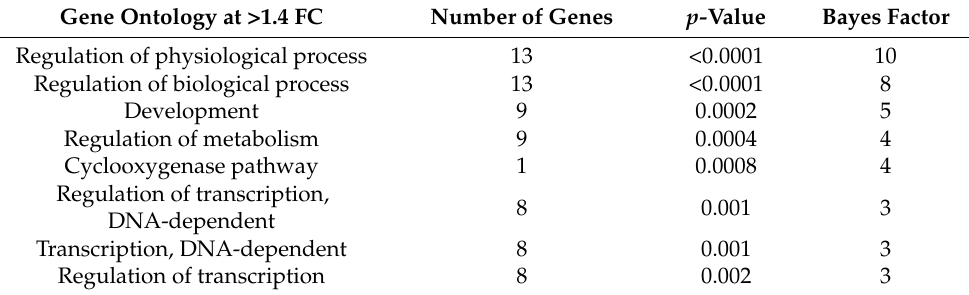
Table A4. Results generated in Gene Annotation Tool to Help Explain Relationships (GATHER) using the Gene ontology (GO)